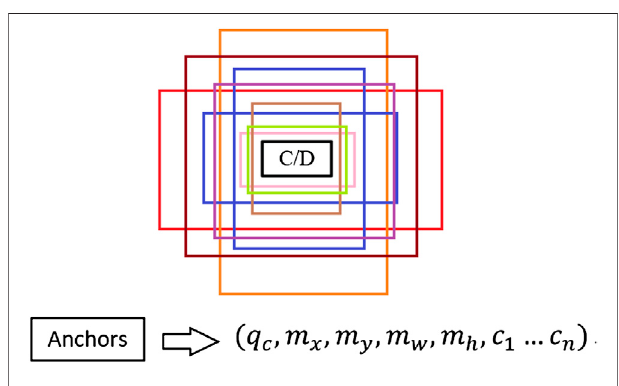
FIGURE 4 | Sample of anchors and area